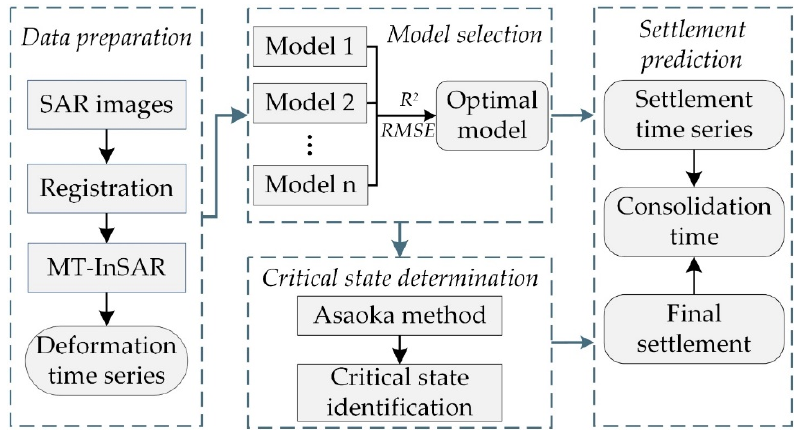
Figure 4. Flowchart of the settlement prediction.